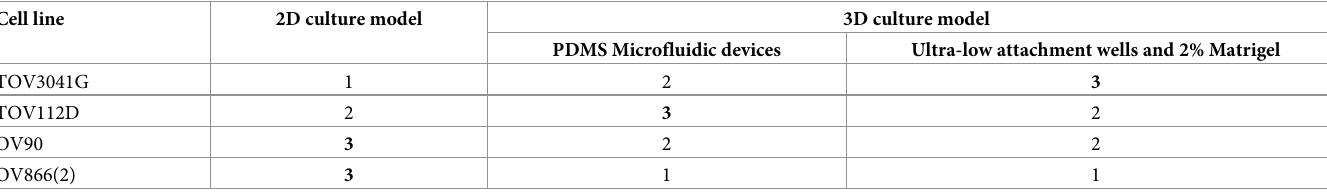
Table 2. Relative carboplatin sensitivity of four EOC cell lines in three different culture conditions. Cell